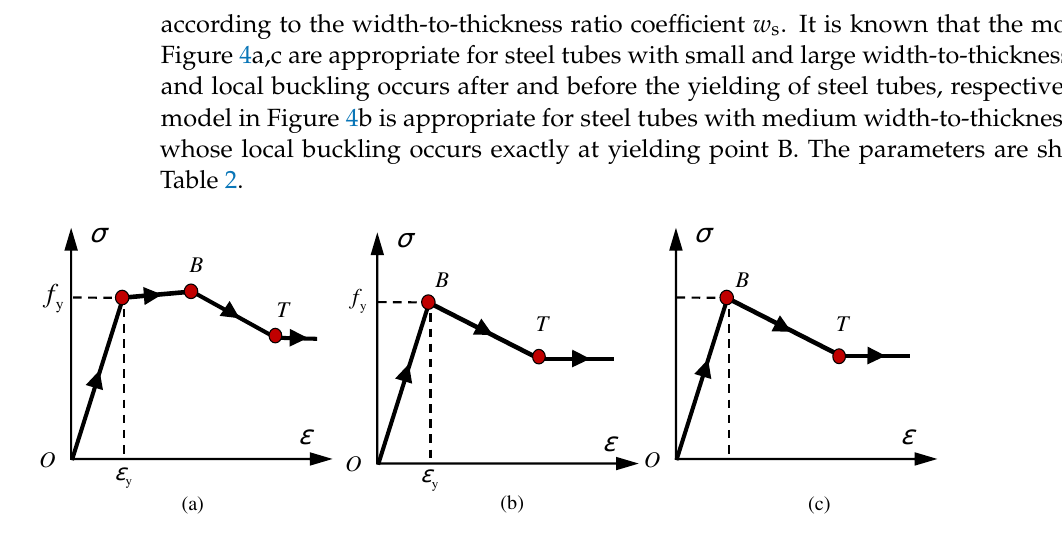
Figure 4. The compressive stress–strain model of steel. ( a ) Small width-to-thickness ratio ( b ) Medium width-to-thickness ratio ( c ) Large width-to-thickness ratio. Table 2. The parameters of equivalent compressive stress–strain model of steel (Sakino et al. [29]).